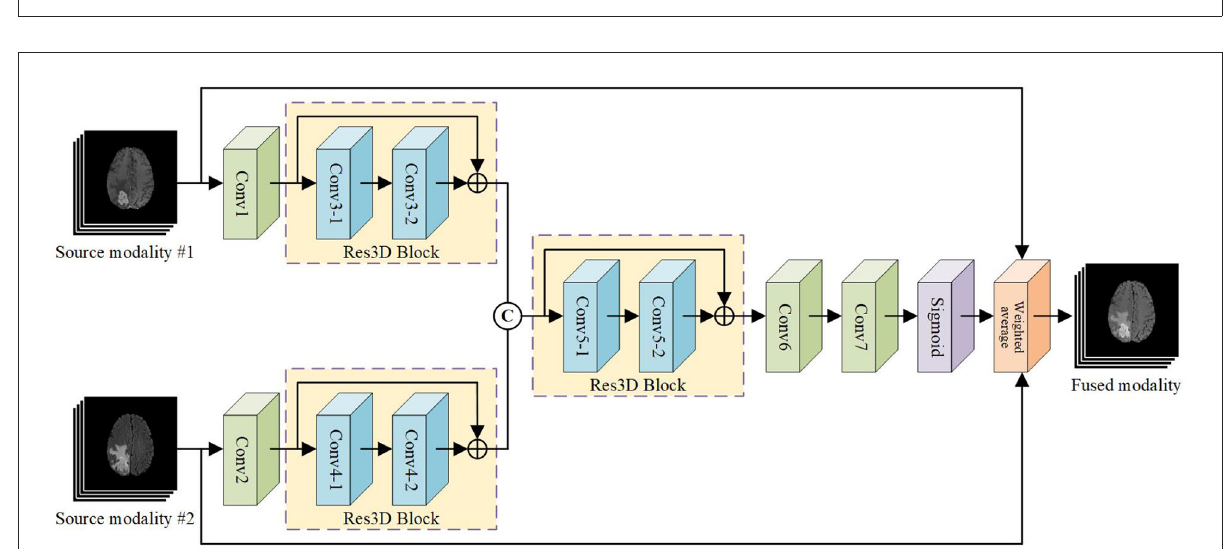
FIGURE2 The schematic diagram of the proposed brain tumor segmentation framework.